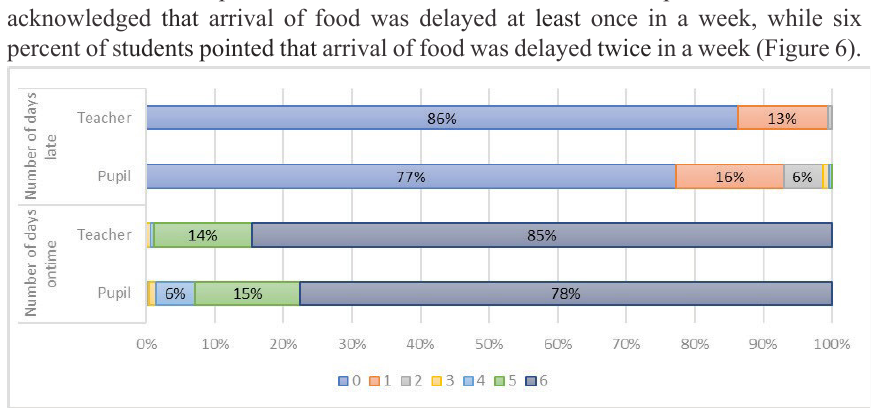
Fig. 6: Perception of Punctuality Regarding the Arrival of Meals at Schools